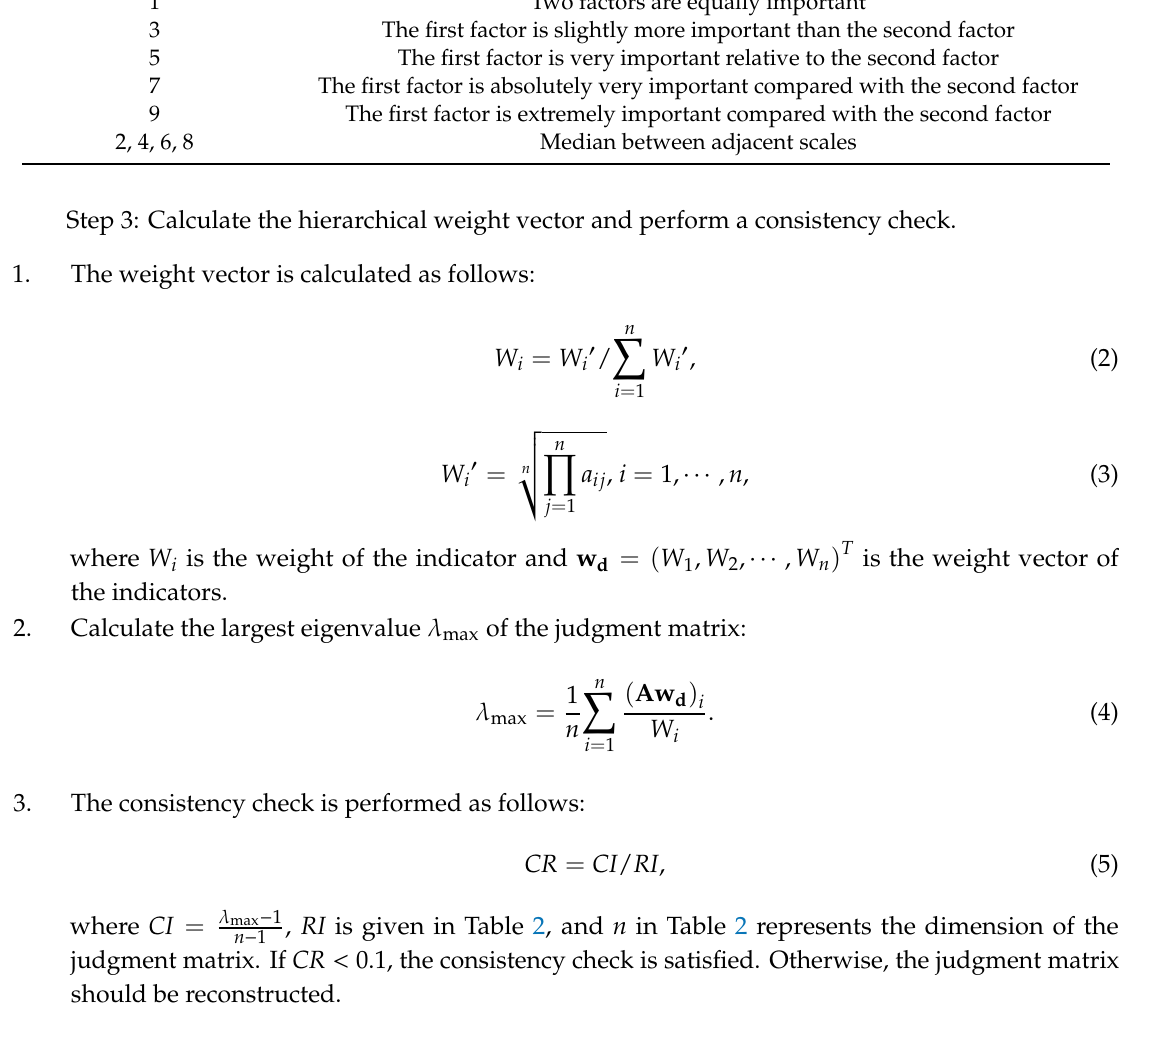
Table 2. Random consistency index ( RI